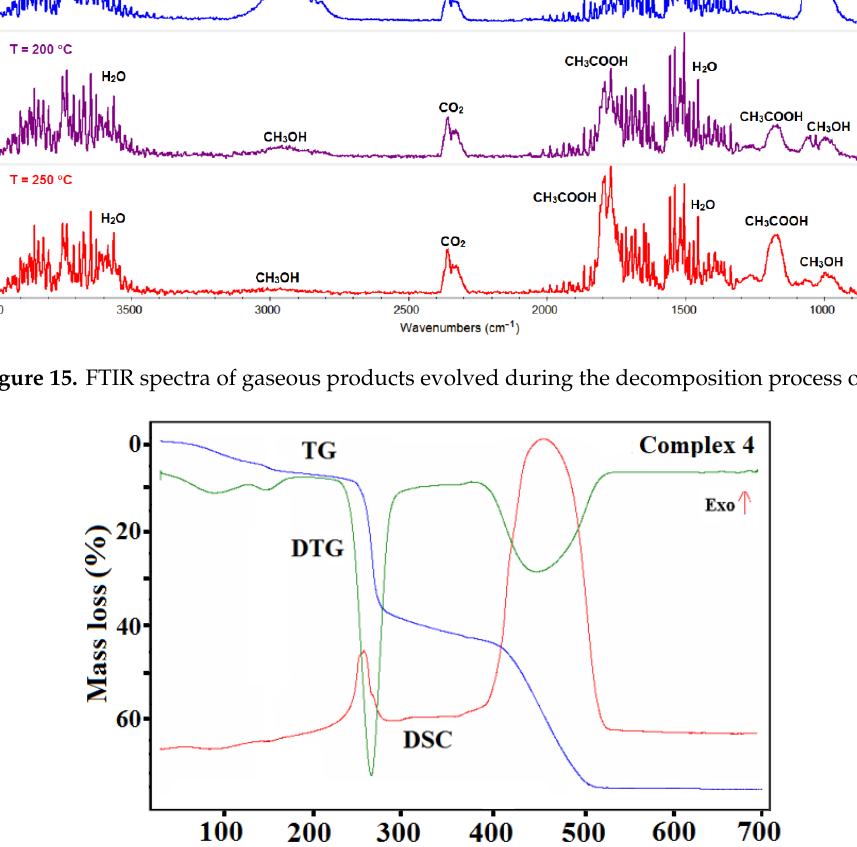
Figure 16. TG, DTG, and DSC curves of the thermal decomposition of complex 4 in air.